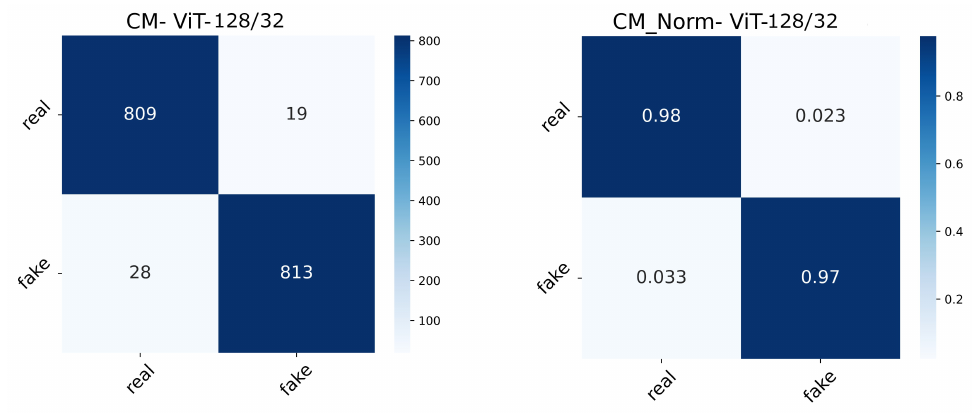
Figure 15. Confusion matrix (normal and normalized) of the ViT128/32 setting.